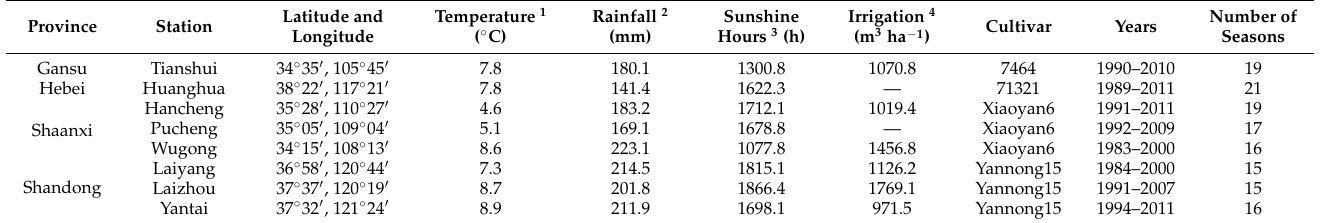
Table 1. Source of the dataset used in the present